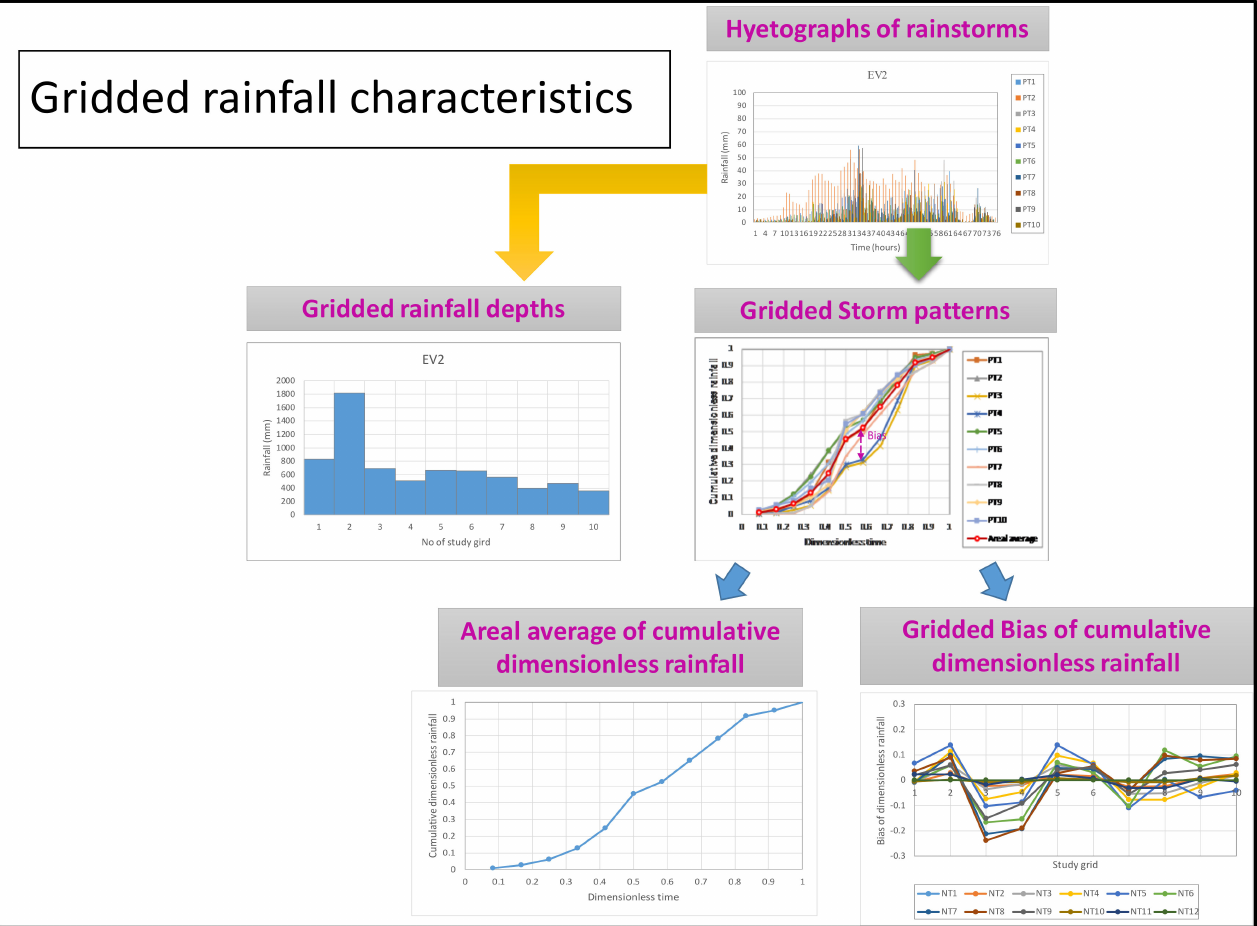
Figure 1. Graphical process of extracting the gridded rainfall characteristics from observed hyetographs of rainstorm events